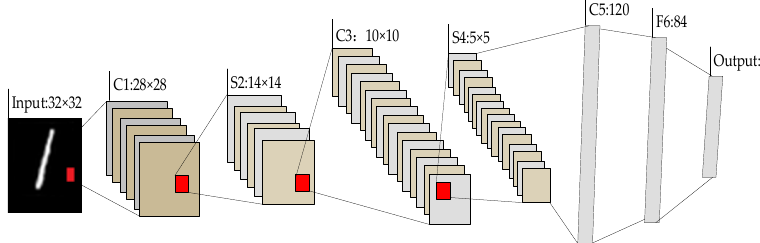
( d ) Figure 3. ( a ) Response curves of TGS2603 to CO at 50 ppm concentration at different injecting times; ( b ) Response of 12 sensors to CH 4 at four concentrations; ( c ) Response of 12 sensors to CO at four concentrations; ( d ) Response of 12 sensors to gas mixtures (50 ppm CO + 500~2000 ppm CH 4 ). 3. The Structure of CNN 3.1. The LeNet-5 Structure LeNet-5 is a gradient-based learning CNN structure and first successfully applied in hand- written digital character recognition [17]. The typical LeNet-5 structure diagram is shown in Figure